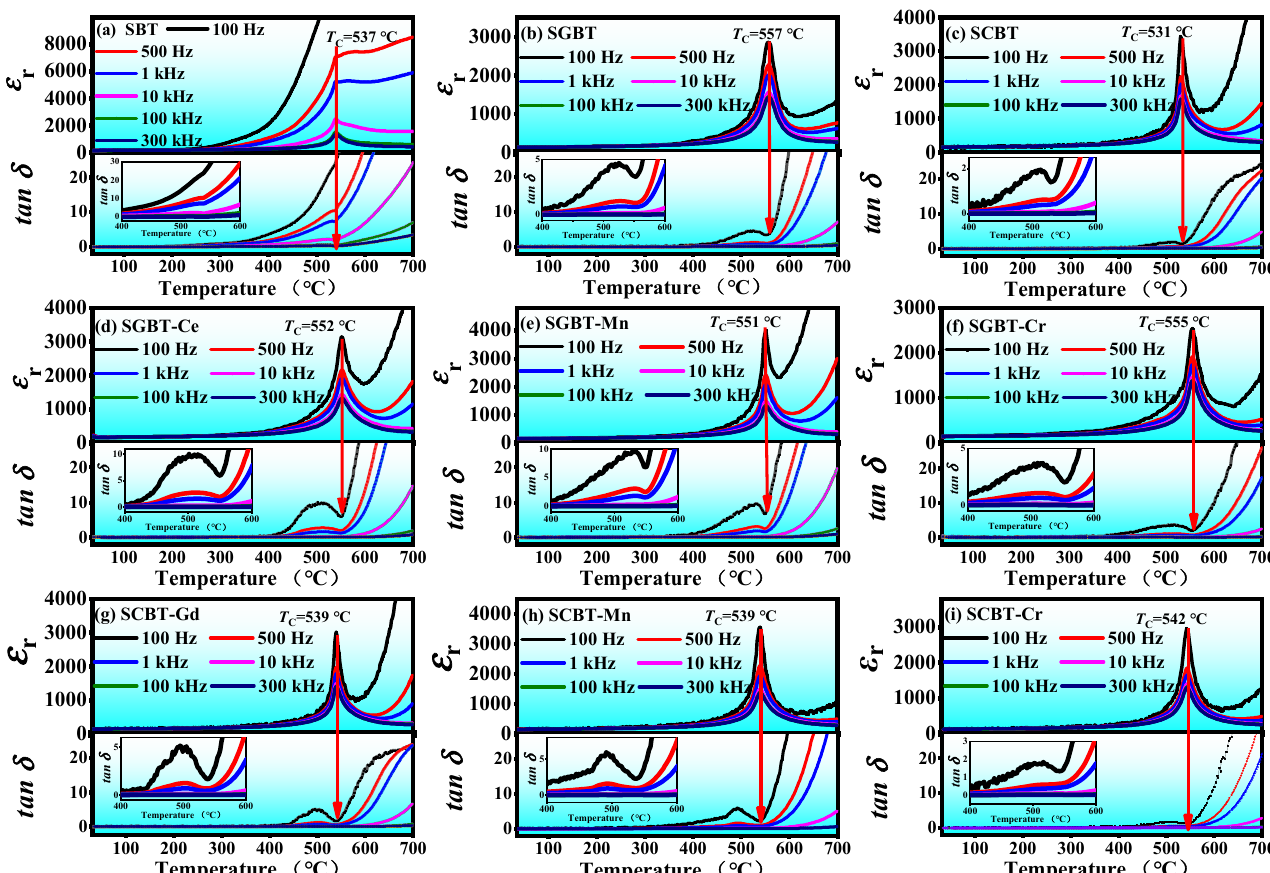
Figure 3. Temperature dependence of dielectric constant and loss tangent of the oxide-modified SBT ceramics at different frequencies.